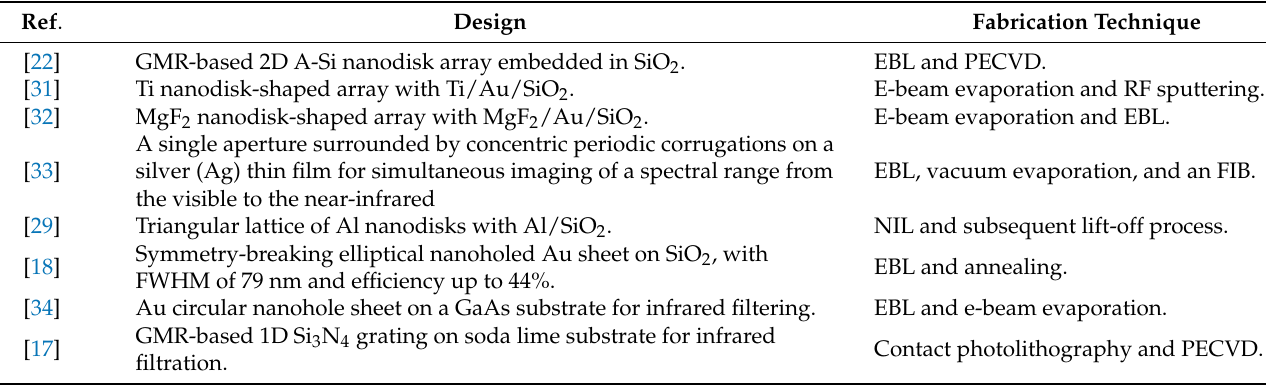
Table 1. Summary of literature